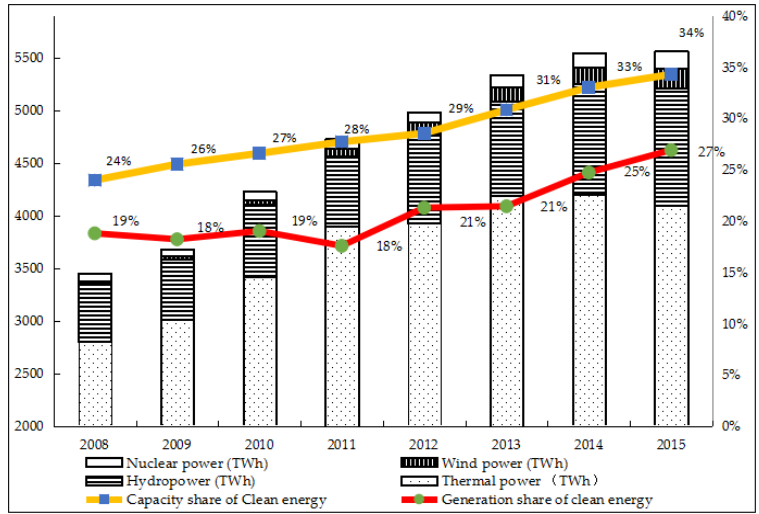
Figure 2. Power generation and the share of clean energy in China’s power sector (2008–2015).